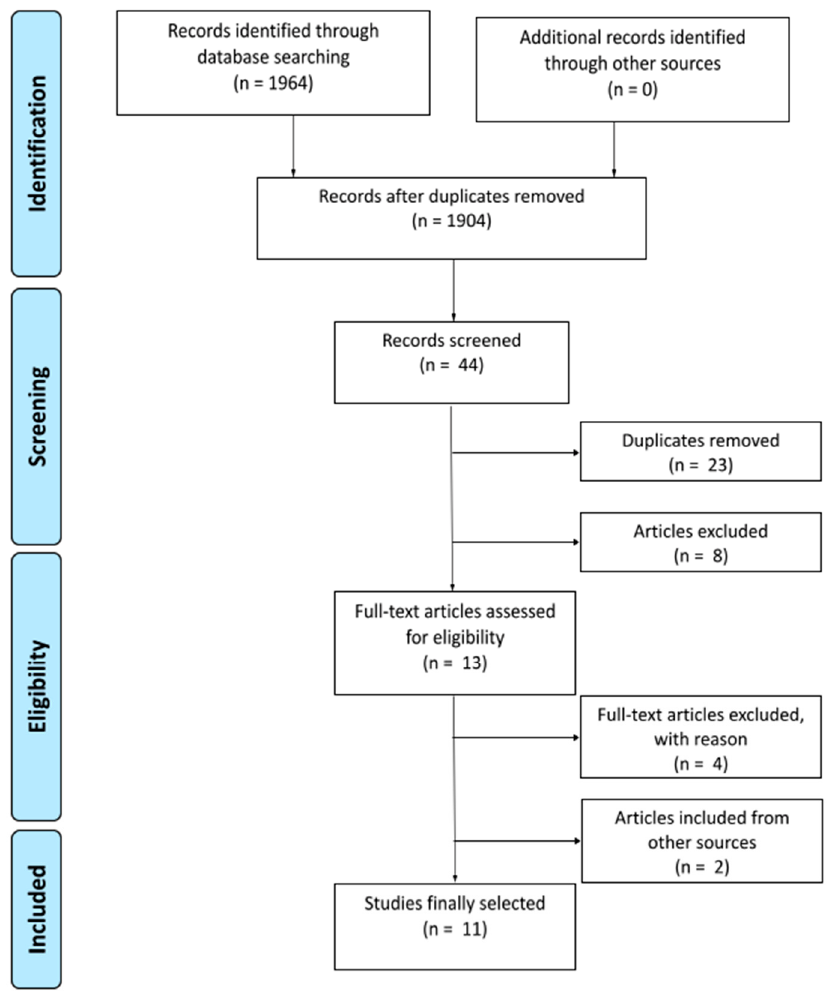
Figure 1. PRISMA flow diagram for study selection process of pre-sleep casein supplementation articles.